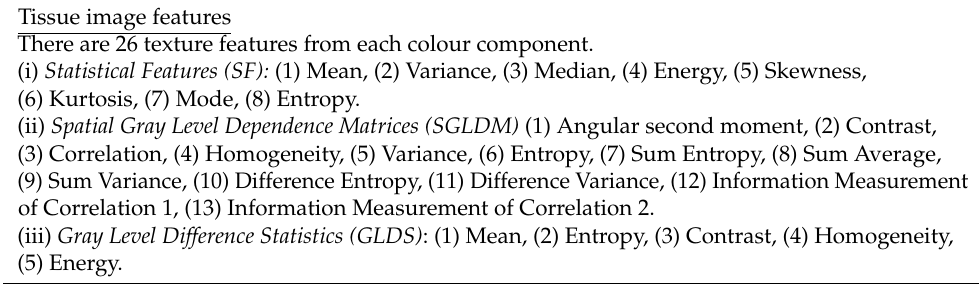
Algorithm and Statistical